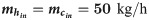
Time evolution of mass production at mhin=mcin=50kg/h.